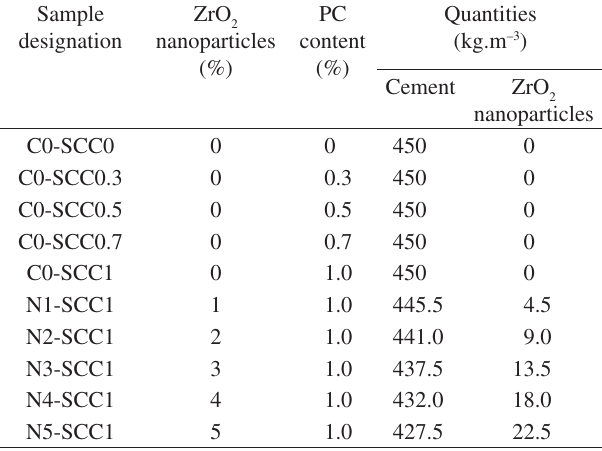
particles blended concretes. 2